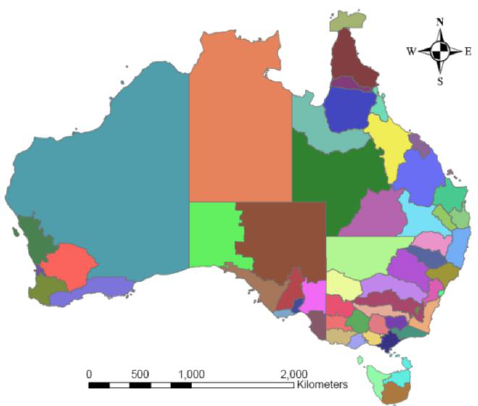
Figure 2. NRM regions